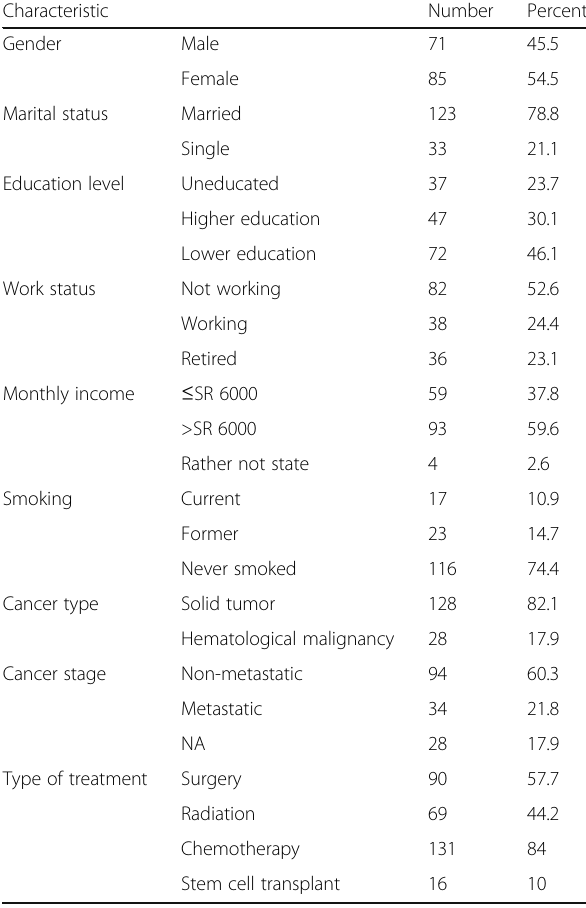
Table 1 Participants ’ characteristics ( n =